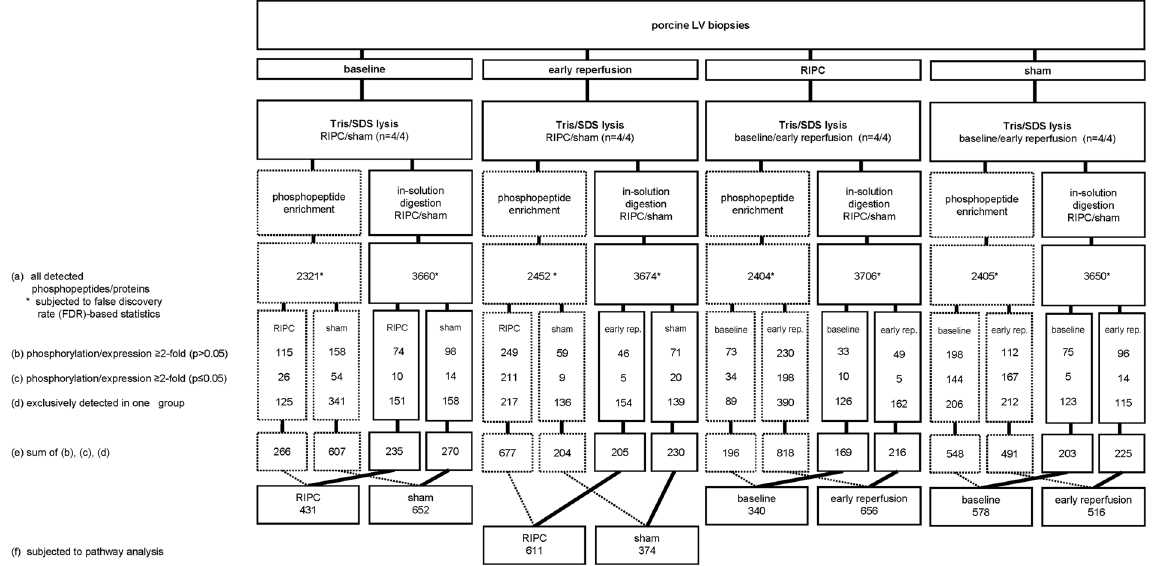
Figure 5. Flow chart of sampling and proteome analysis of porcine left ventricular biopsies. Porcine left ventricular (LV) biopsies from pigs without (sham) or with remote ischemic preconditioning (RIPC) were taken at baseline and at early reperfusion and lysed in Tris/sodium dodecyl sulfate buffer (Tris/SDS). Proteome analysis was performed after phosphopeptide enrichment and in-solution digestion. The numbers of all detected phosphopeptides/proteins were displayed in line (a), those with ≥ 2-fold higher phosphorylation/ expression in line (b), these with significant (p < 0.05) ≥ 2-fold higher phosphorylation/expression between groups (RIPC/sham) or between time points (baseline/early reperfusion), respectively, in line (c), and those exclusively detected in one group (RIPC/sham) or at one time point (baseline/early reperfusion) in line (d). The sum of lines (b), (c) and (d) was displayed in line (e). All detected phosphopeptides/proteins (line (a)) were subjected to false discovery rate (FDR)-based statistical analysis. All proteins detected at early reperfusion with a ≥ 2-fold higher phosphorylation/expression with RIPC than with sham (line (f)), were considered for an in- silico pathway